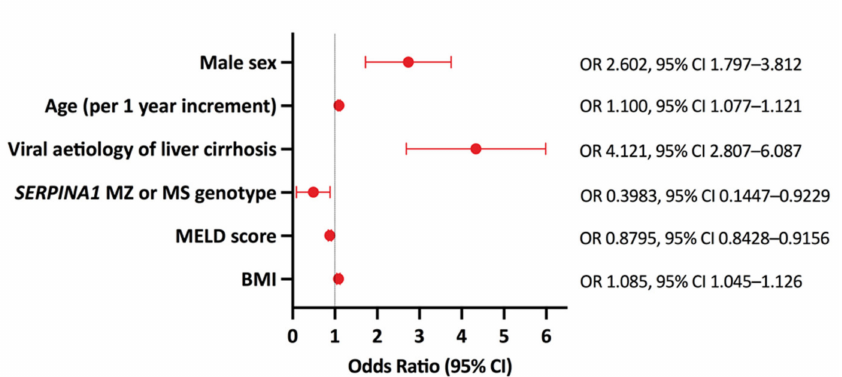
Figure 4. Multivariate logistic regression analysis of risk factor of HCC in the cirrhotic group. BMI, Body Mass Index; CI, Confidence Interval; MELD, Model for End Stage Liver Disease; OR, Odds